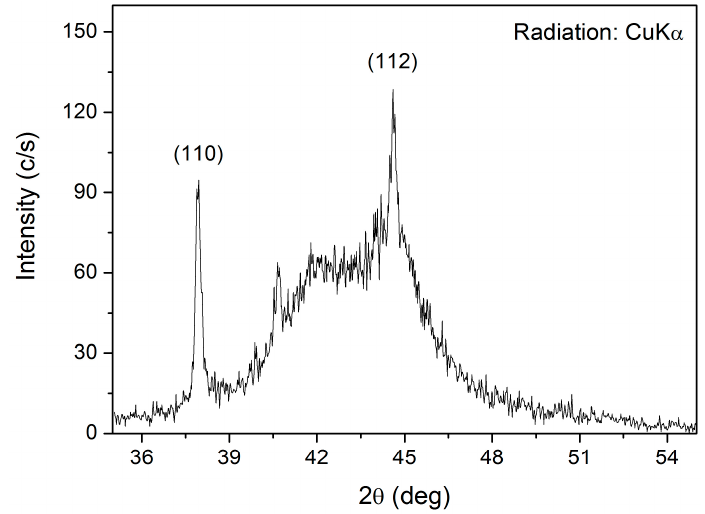
Figure 5. SEM micrograph of sponge ‐ like porous Fe 2 Mo powder particle used for unidirectional compaction.